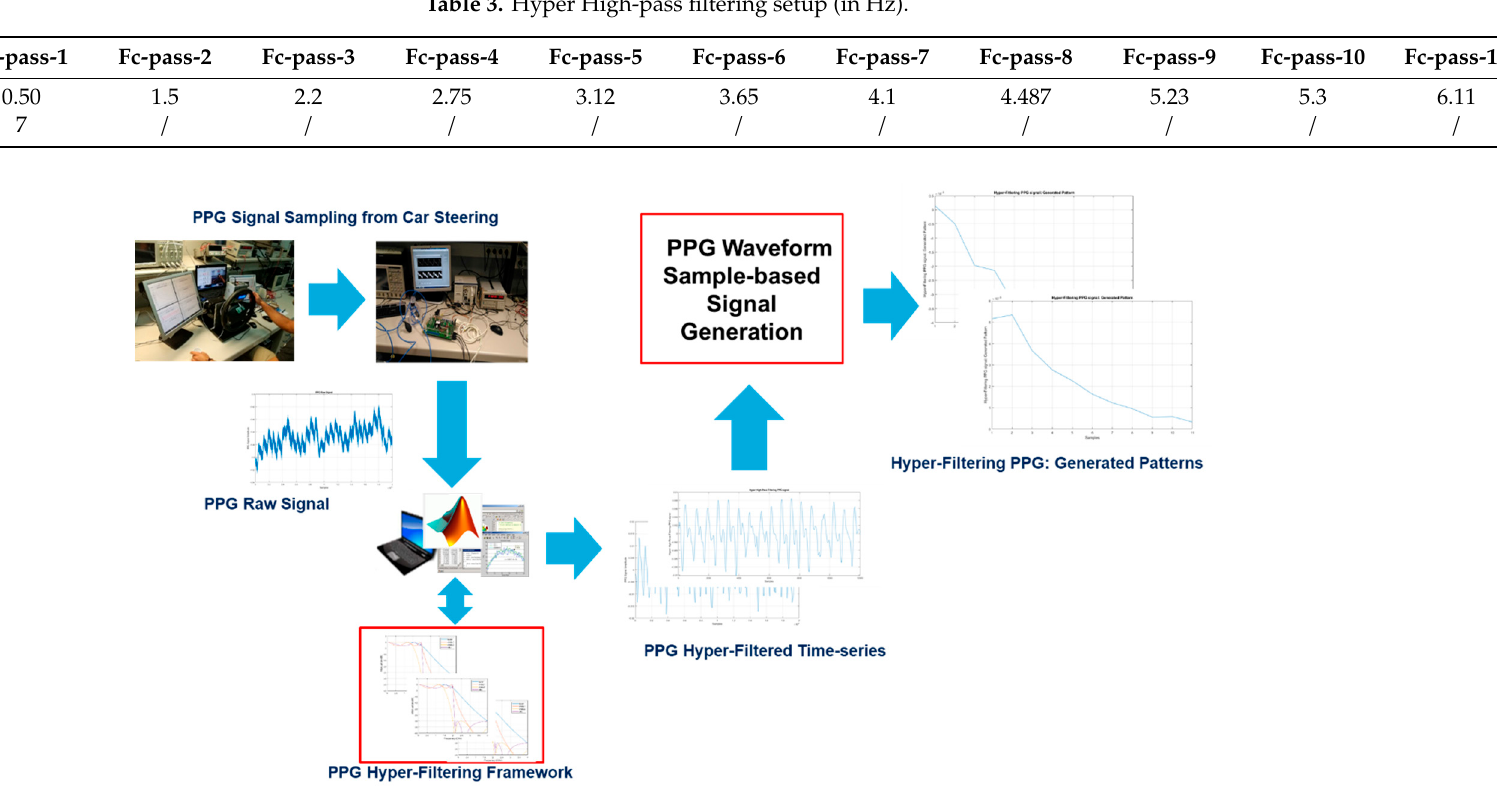
/ low-pass implemented system Figure 8. Hyper-filtering high-pass/low-pass implemented system setup. Figure 8. Hyper-filtering high-pass